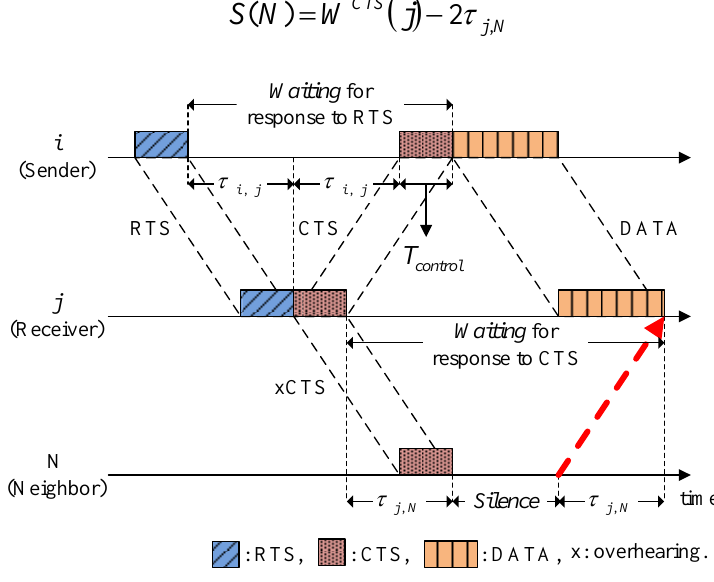
Figure 3. Illustration of the Waiting and Silence.